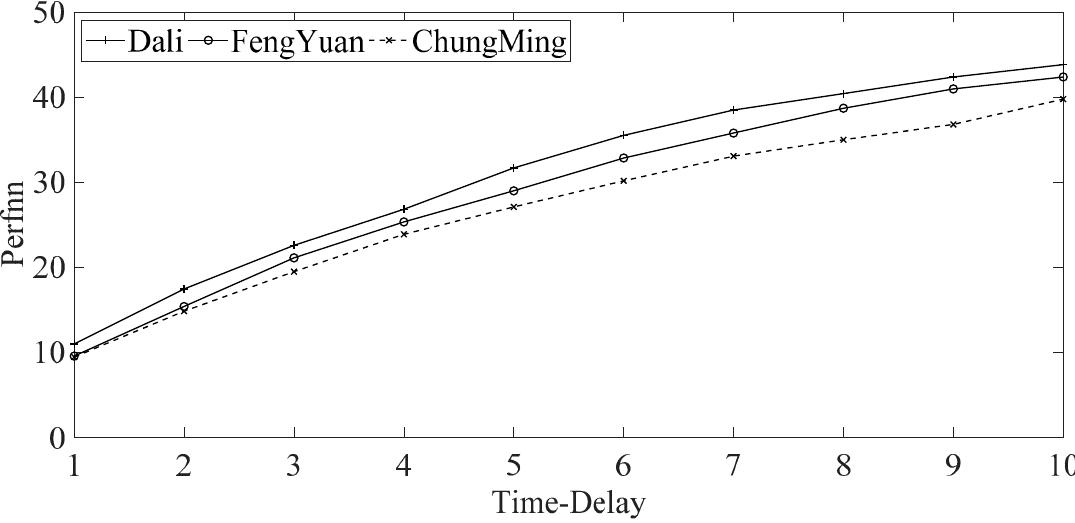
Figure 11. Corresponding relationship between the value of time-delay terms and Per fnn in modified false nearest neighbor method (MFNNM).